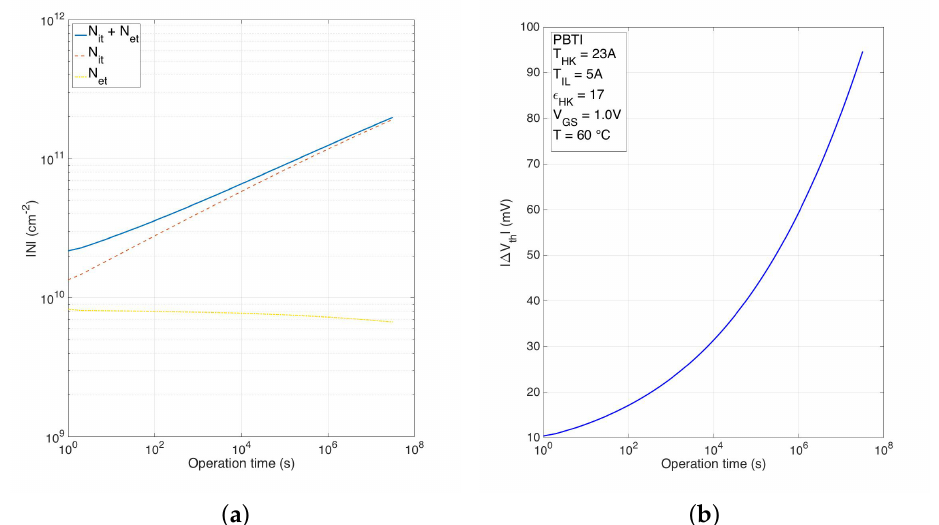
Figure 8. Components that constitute the PBTI phenomenon under different operation conditions. ( a ) Interface trap generation ( N it ), electron trapping ( N et ), and the sum of both N it and N et components, and ( b ) the absolute threshold voltage